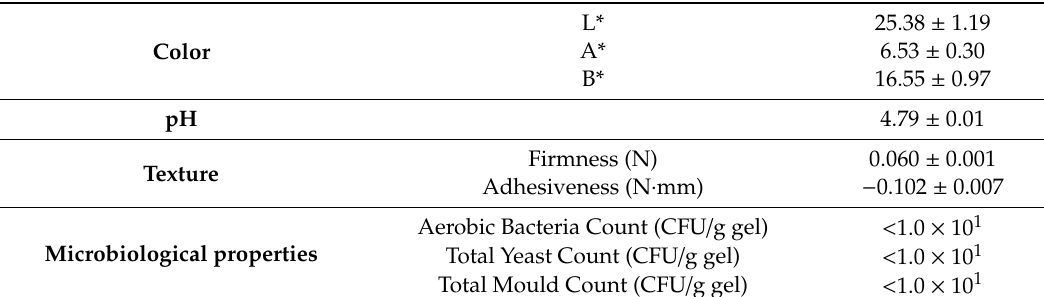
Table 3. Physical and microbiological properties of gel formulation prepared with Loureiro subcritical water extract evaluated at 25 ◦ C at initial time; values are means ± SD ( n =